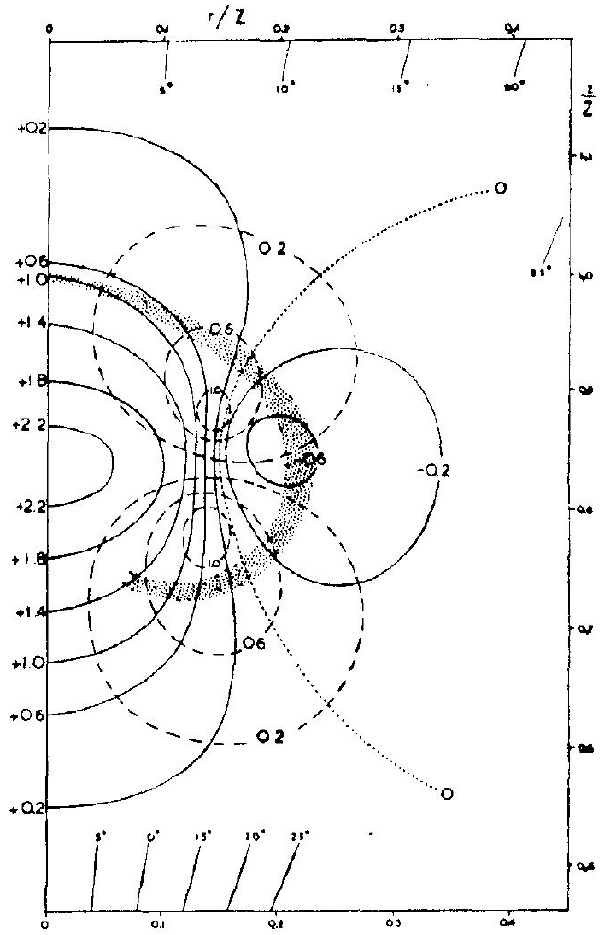
Figure 2. The distribution of velocity in and around an isolated ther- mal. Only the right-hand side of the thermal is shown. The outline of the buoyant fluid is shaded. The solid and dashed lines show the vertical and radial velocities, respectively, with the values indicated as multiples of the vertical velocity of the thermal cap (reproduced from Fig. 2 of Woodward,